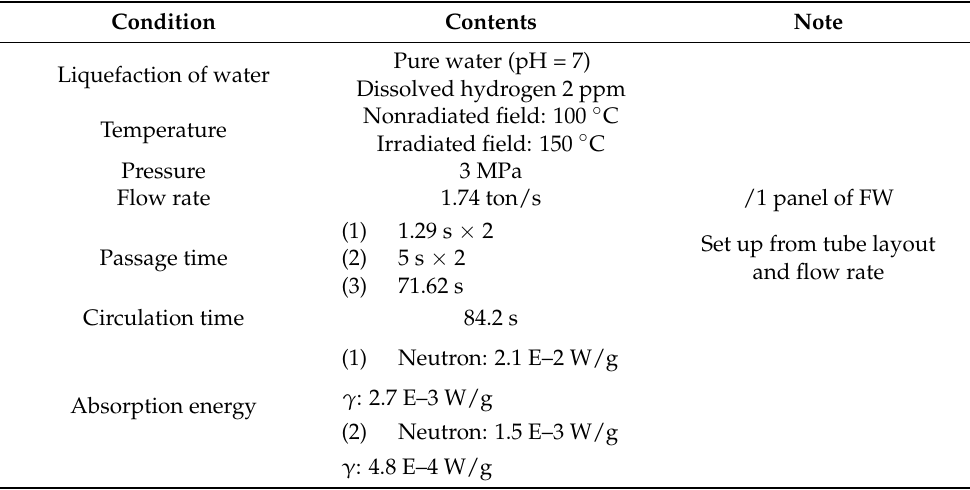
Table 12. Analytical conditions assumed in [25] in modeling the production of H 2 and O 2 in the blanket PHTS of